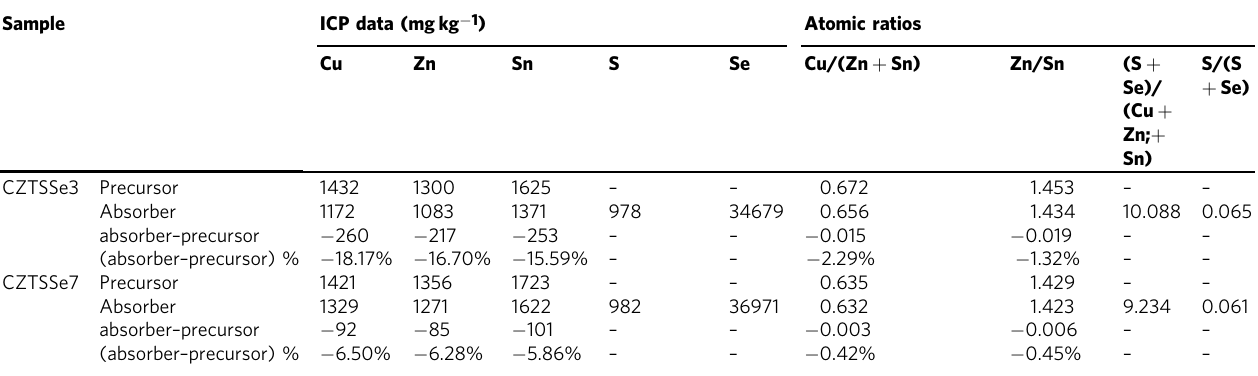
Table 2 Element ratios in the CZTSSe absorber layers for fl exible CZTSSe3 and CZTSSe7 solar cells determined using an inductively coupled plasma (ICP) emission spectrometer